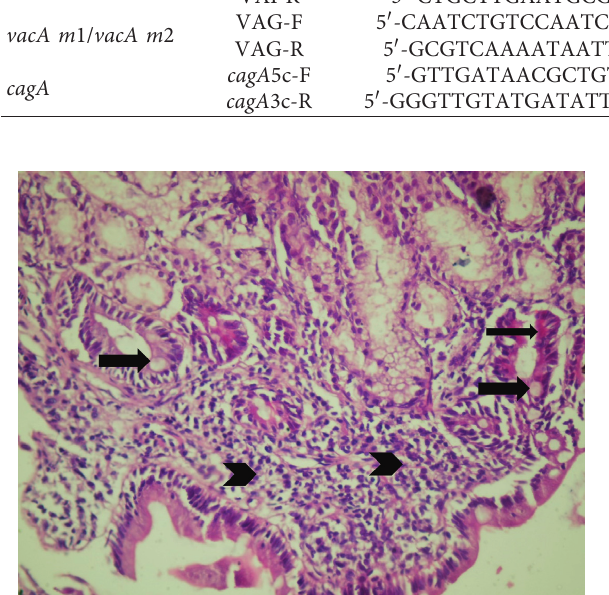
Figure 1: Photomicrograph showing antral chronic superficial gastritis with mixed inflammatory cell infiltrate (arrow heads), mainly lymphocytes and plasma cells; some glandular epithelial cells show intestinal metaplasia, with goblet cells (thick arrow) and Paneth cells (thin arrows), H&E, × 200.